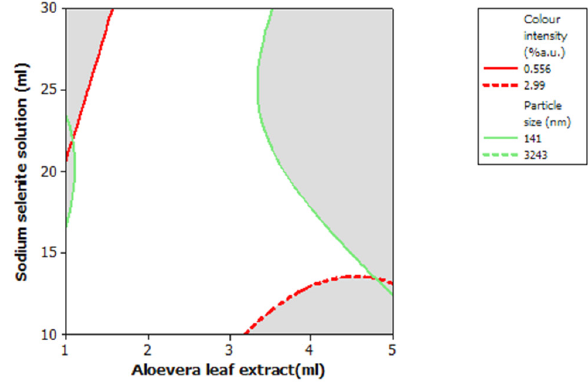
SeO solution and Figure 7: TEM image of the synthesized Se NPs at obtained 2 3 optimum